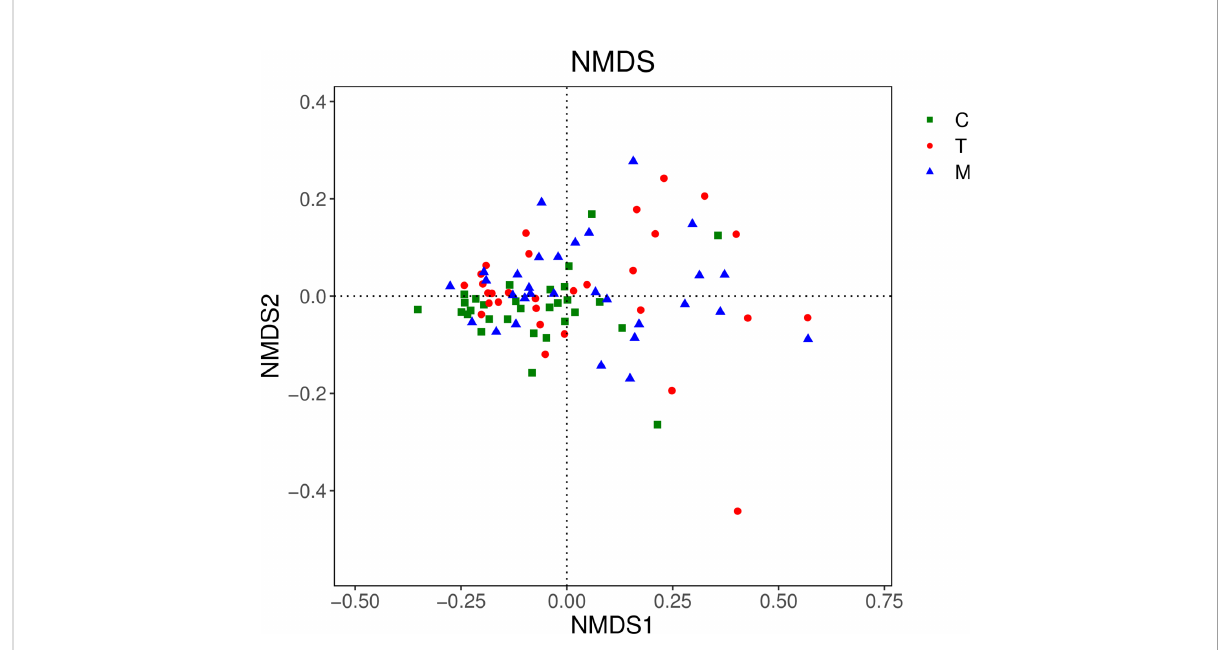
FIGURE 4 NMDS diagram of the general control group and the experimental